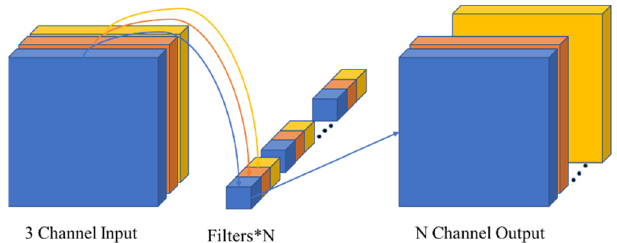
Figure 3. Pointwise convolution operation.